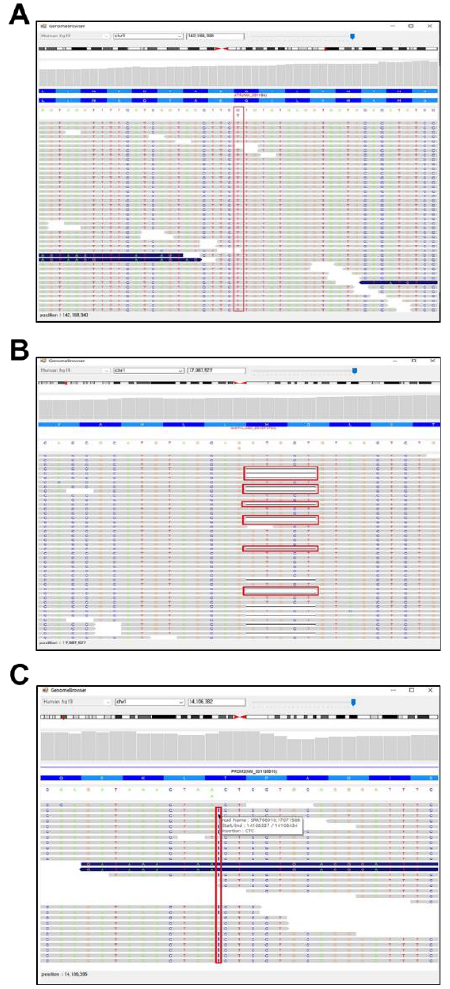
Figure 4. Identification of genetic variants in a genome browser with a single-nucleotide resolu- tion. ( A ) Single nucleotide polymorphism (SNP) in an ATR gene. ( B ) Deletion in a MST1L gene. ( C ) Insertion of the sequences in a PRDM2 gene. The positions of genetic variants are indicated with red